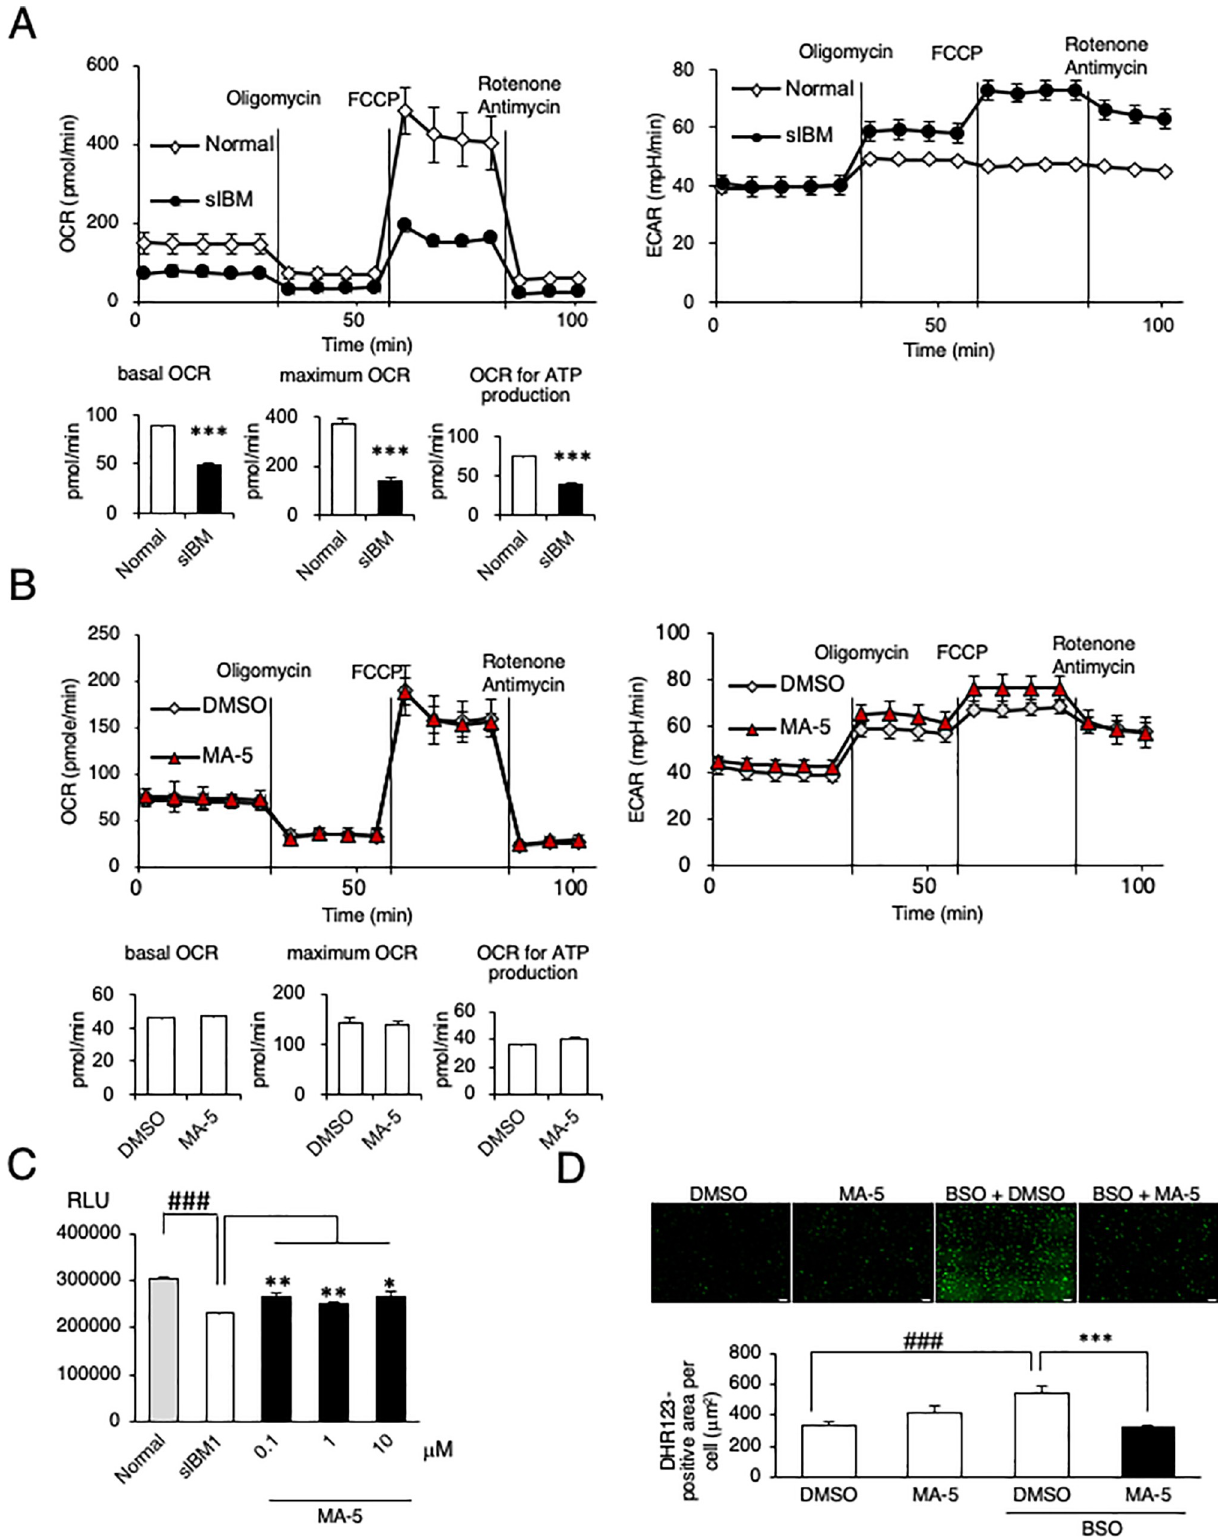
Fig 5. Effect of MA-5 on mitochondrial respiration in sIBM skin fibroblasts. A. Bioenergetic assay of normal and sIBM patient fibroblasts (sIBM1) in comparison with the OCR (left) and ECAR (right). The data represent the mean ± SD. B. Bioenergetic assay of fibroblasts from sIBM patients treated with DMSO or MA-5 (10 μ M). The data represent the mean ± SD. C. MA-5 increased the ATP level of fibroblasts from normal controls and sIBM